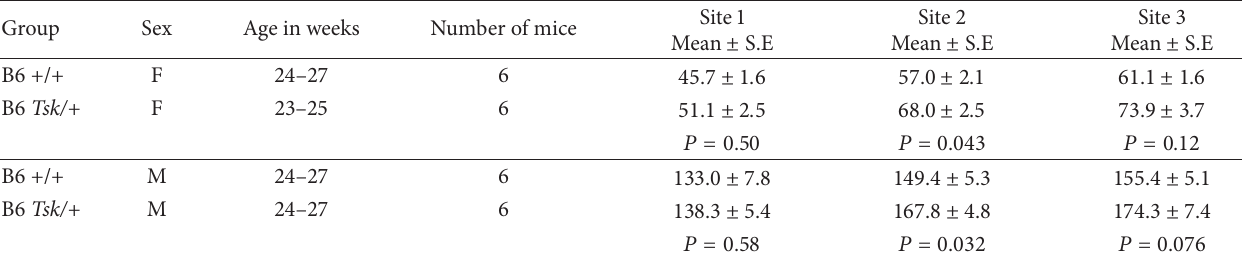
Table 1: Hydroxyproline content in skin of B6 +/+ and B6 Tsk /+ mice.